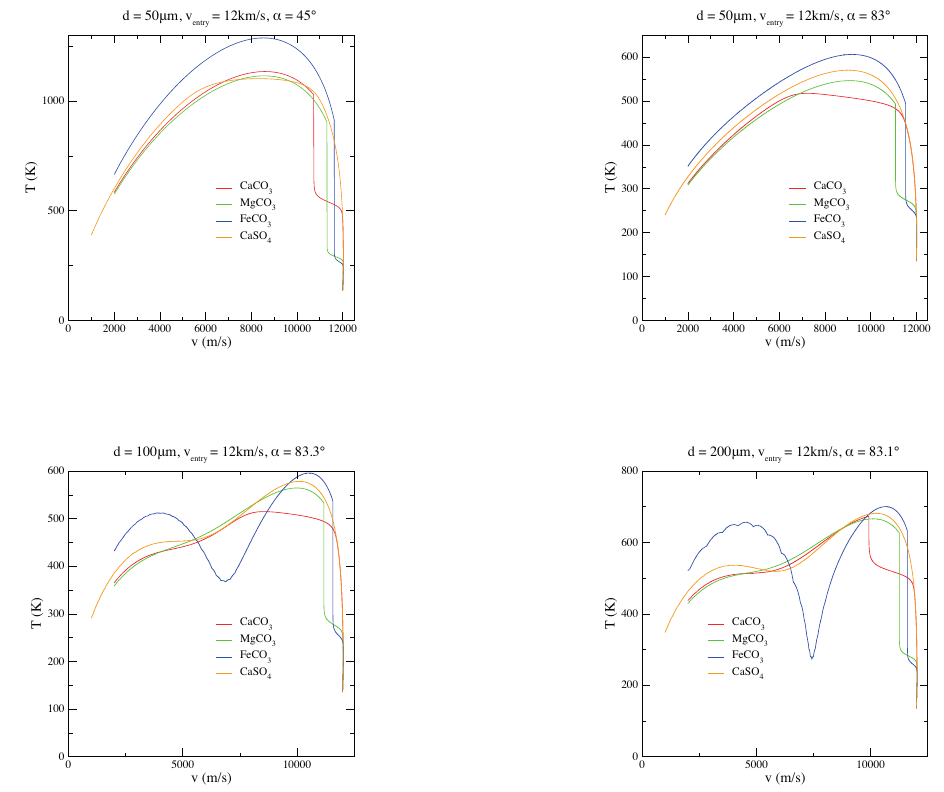
Figure 4. Comparisons among MgCO 3 , CaCO 3 , FeCO 3 , and CaSO 4 micrograin velocity trend in the case of various diameters ( d ), velocities (v entry ), and entry angles ( α ) of the